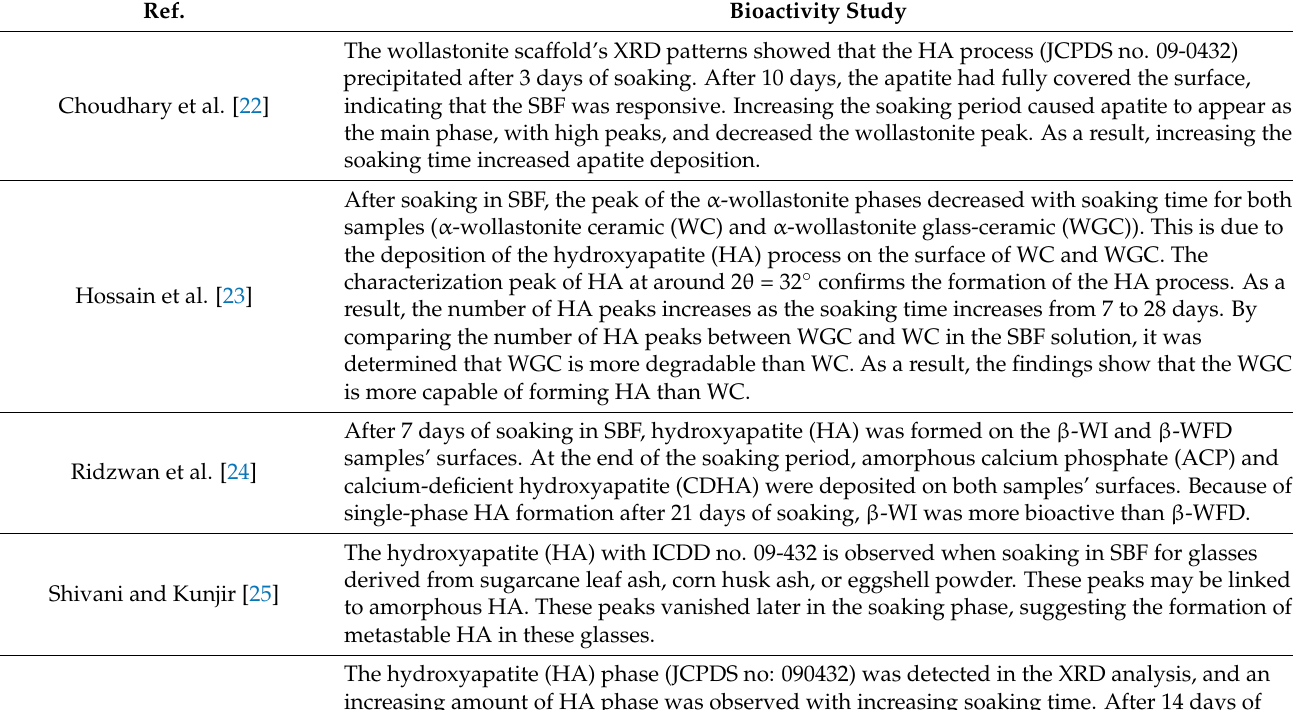
Table 10. Summary of in vitro studies on the bioactivity of wollastonite derived from RHA and RSA.